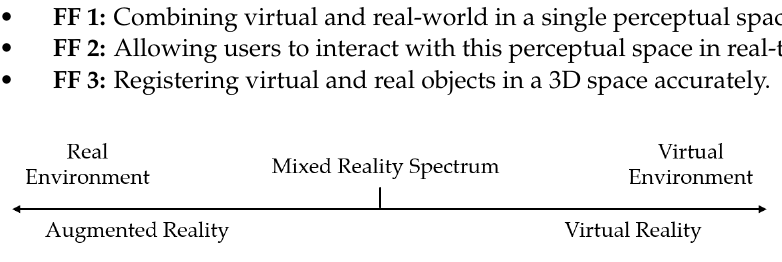
Figure 1. The Reality-Virtuality Continuum according to Milgram et al.